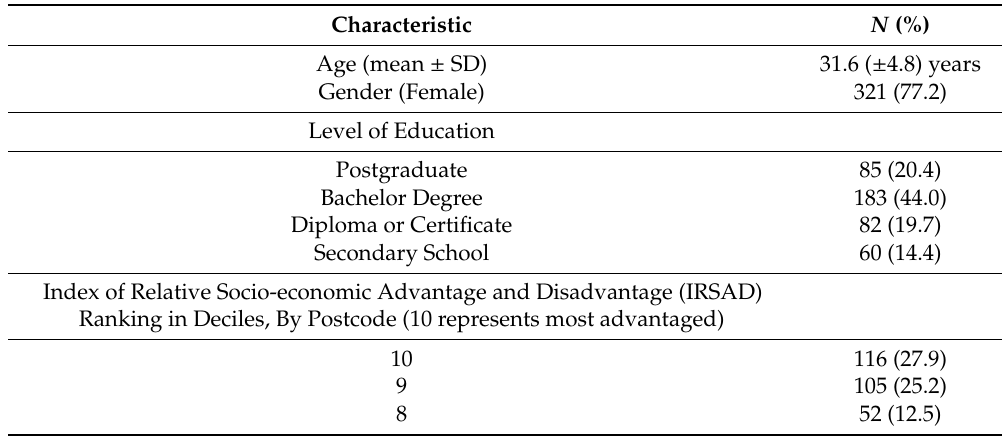
Table 2. Baseline Characteristics of Participants ( N =